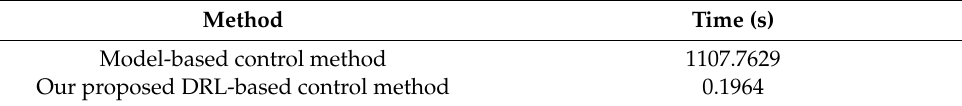
Table 3. Execution time of model-based control method and DRL-based method.